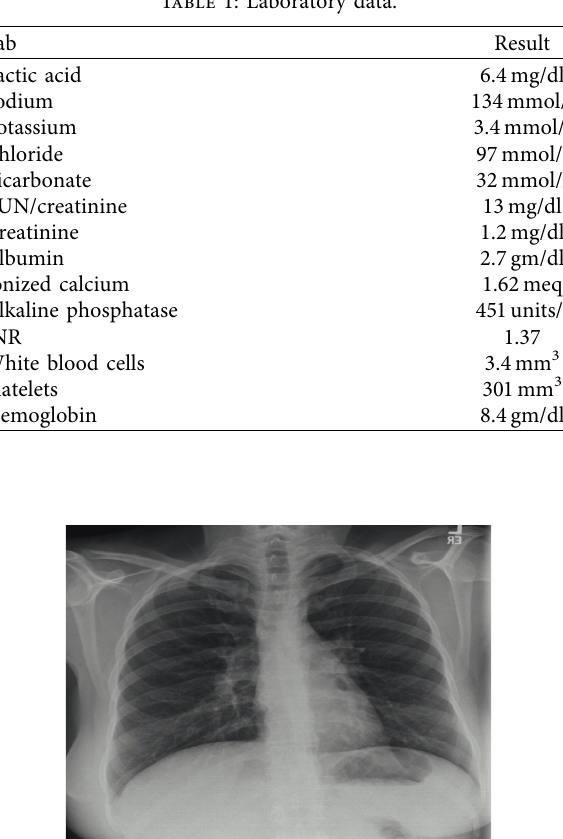
Figure 1: Chest X-ray showing no abnormality or masses.